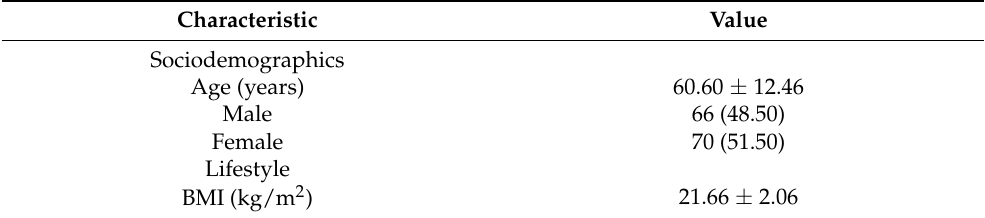
Table 1. Clinical manifestation of